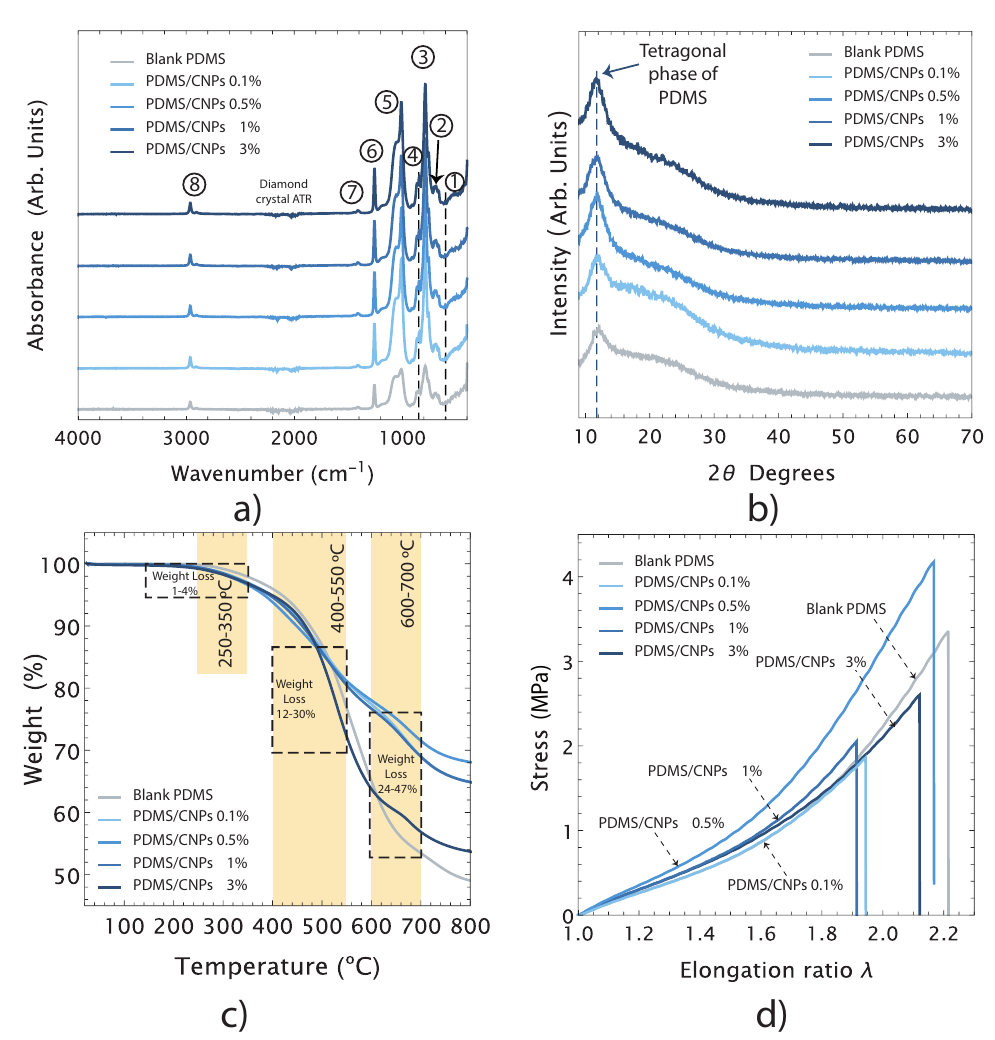
Figure 3. Main physical and chemical features of the nanocomposites: ( a ) chemical features of the nanocomposites determined by FT-IR; ( b ) X-ray diffraction patterns and crystallinity; ( c ) thermal stability by TGA; and ( d ) mechanical behavior under uniaxial tension. Table 1. Characteristic vibrational bands of PDMS and its